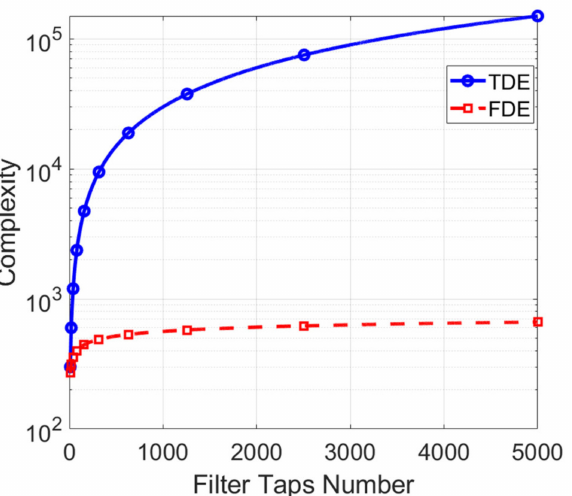
Figure 2. Number of multiplies per symbol vs. filter tap length for TDE and FDE. FDE can signifi- cantly reduce the computational complexity (m =